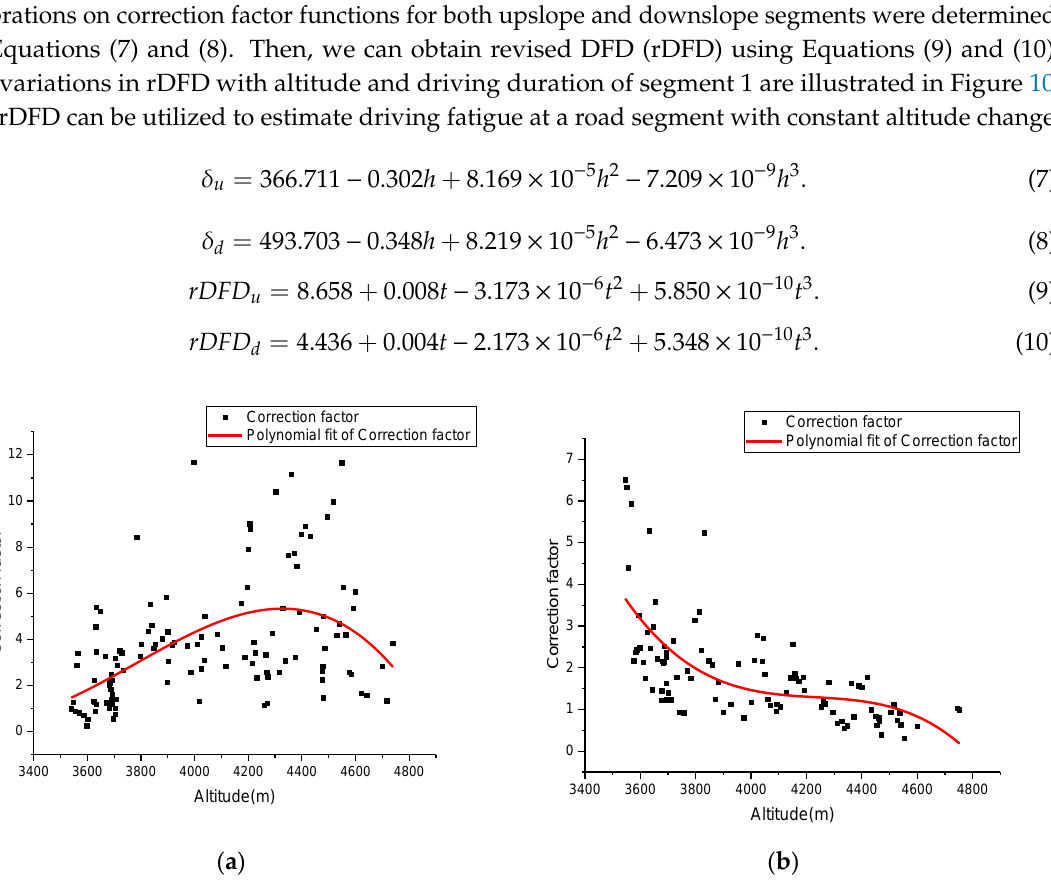
Figure 9. Variations in correction factor δ for segment 1: ( a ) upslope road segment and ( b ) downslope road segment.